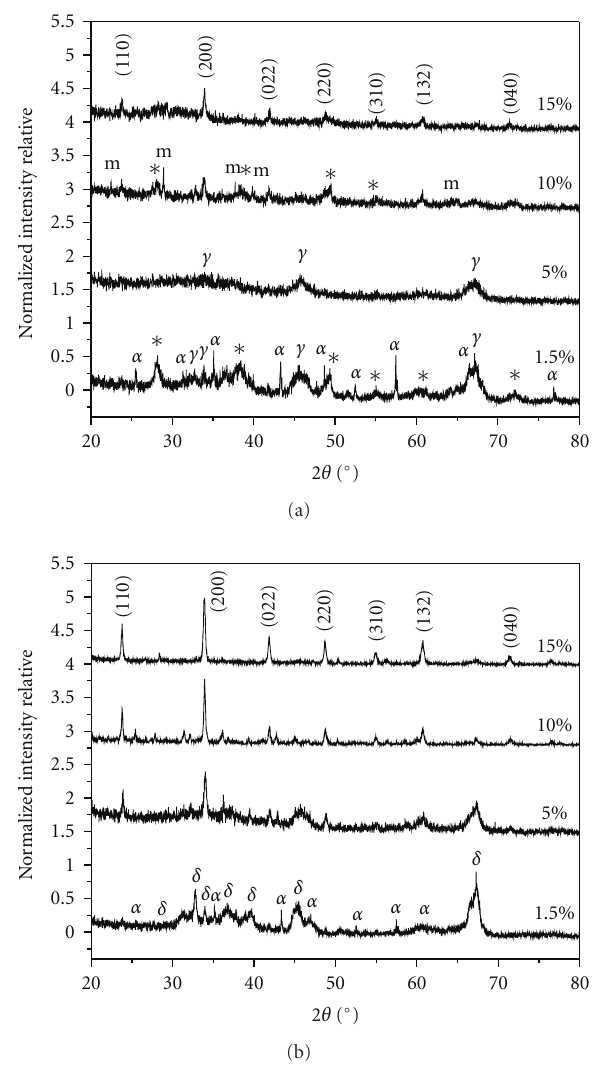
Figure 1: (a) XRD patterns of the as-synthesized red-emitting phosphor powders produced by the PACS method. Principal peaks are labeled and correspond to the crystalline phases: ( α ) α -Al 2 O 3 (JCPDS #50-1496), ( γ ) γ -Al 2 O 3 (JCPDS #10-0425), ( ∗ ) AlOOH (JCPDS #21-1307). Peaks of the 10.0 at % Eu-doped sample are labeled with “m” (JCPDS #72-0683). Below, (b) XRD patterns of the green-emitting phosphor powders produced after RIRO. Principal peaks are labeled and correspond to the crystalline phases: ( α ) α - Al 2 O 3 (JCPDS #50-1496) and ( δ ) δ -Al 2 O 3 (JCPDS #46-1131). The principal planes of the orthorombic EuAlO 3 (JCPDS #09-0084) phase are indexed in both cases.